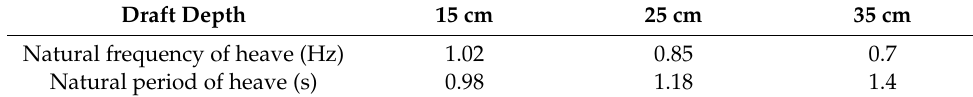
Table 4. The natural period of heave for different drafts.